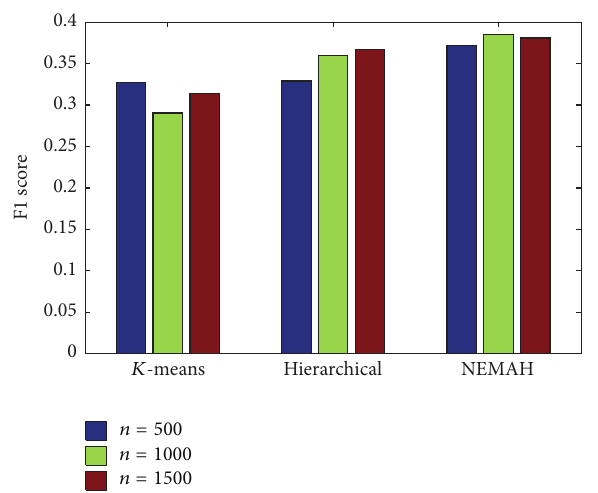
Figure 7: Recommendation performance of different data scales for different clustering based systems. Remark . 𝑛 denotes the number of news articles for clustering.